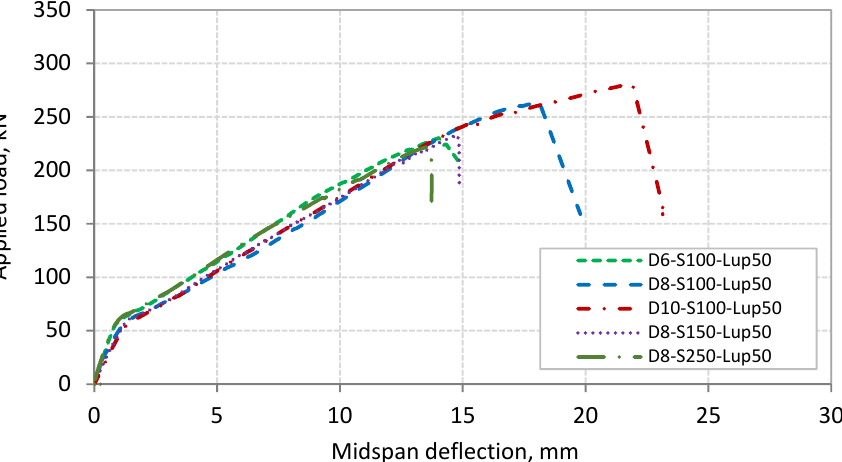
Figure 9. Applied load–deflection relationship for beams of Series 1.